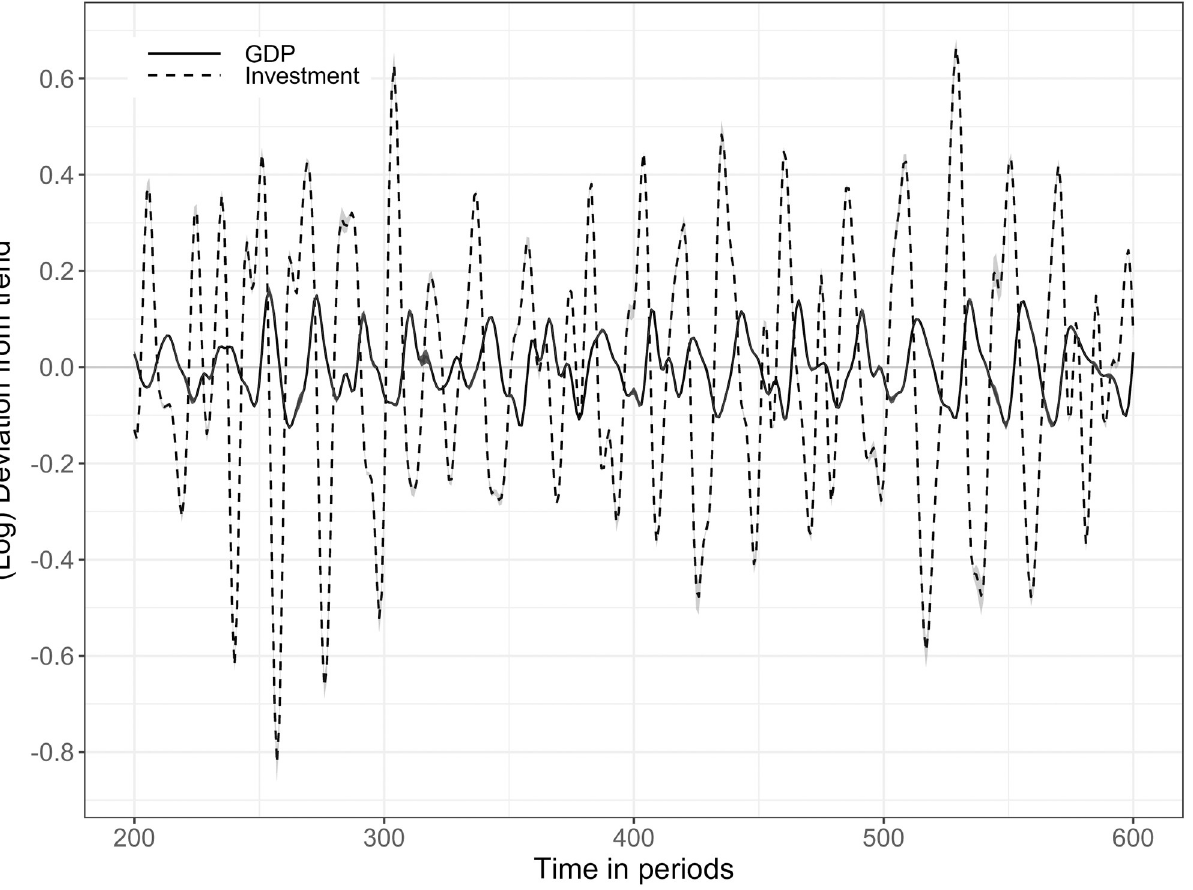
Fig 6. SF1: Deviations of real GDP and real investment time series from trend: Bandpass-filtered (6,32,12). Note: The Figure depicts deviations of average log real GDP (solid line) and average log real firm investment (dashed line) from trend. The simulation output is a representative run and shows an extract to keep the line profile more identifiable without the warm-up phase of 200 simulation periods. The grey shaded area represents the 90% confidence